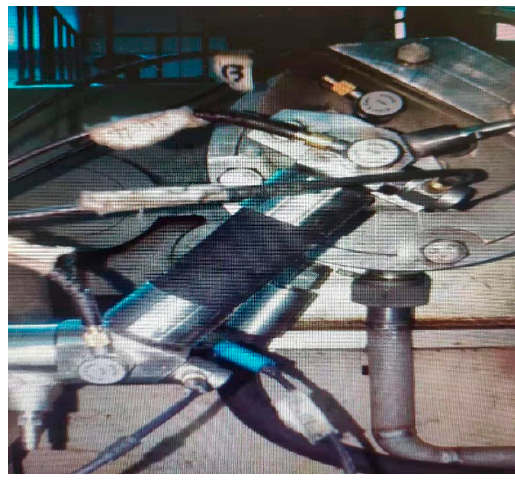
Figure 7. Testing the vibration isolation effectiveness of RP.